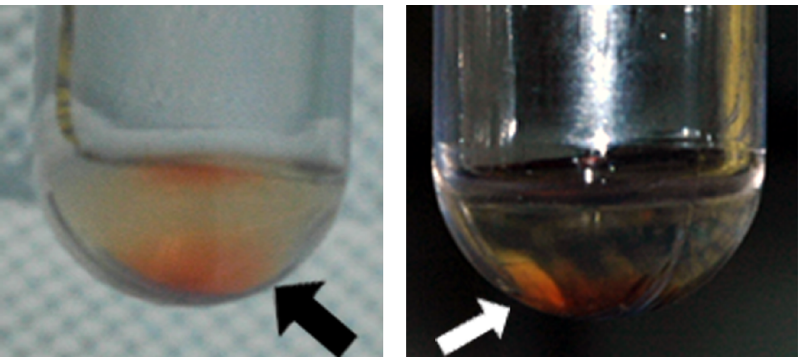
Figure 2. Pictures of a representative microvesicle pellet against different backgrounds. The loose orange-reddish hollow at the bottom of the tubes (shown by arrow) was obtained following ultracentrifugation (200 000 g, 2 h 15 min) of the microparticle-depleted pooled